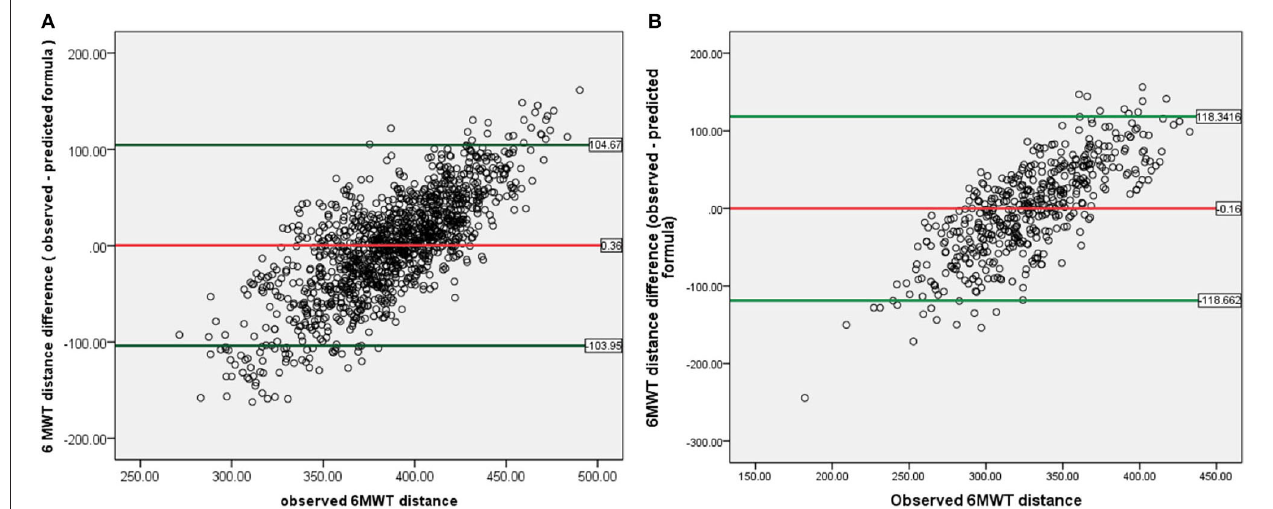
FIGURE 3 | Bland–Altman plot of 6-MWT distance difference between observed and predicted formula, against actual observed 6-MWT distance for 2014–2016 population: (A) CABG group. (B) Valve surgery group. * Red line indicates mean difference between 6-MWT distance predicted and observed and showed values close to 0 for both groups. Green line indicates upper and lower limit agreement of difference in the population. 6-MWT, 6-min walk test; CABG, coronary artery bypass